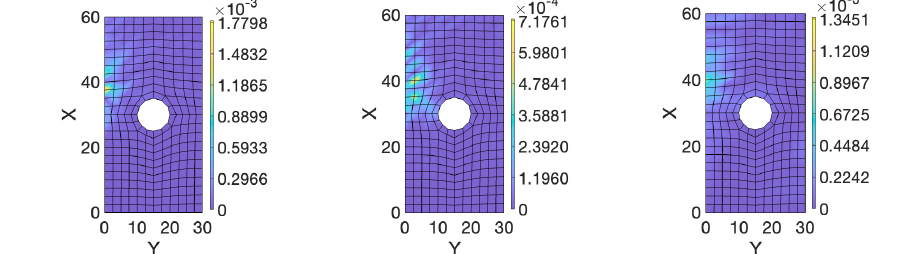
Figure 12. Top view of the difference in absolute value between the corrected and the reference displacement field, for x ( left ), y ( middle ) and z ( right )